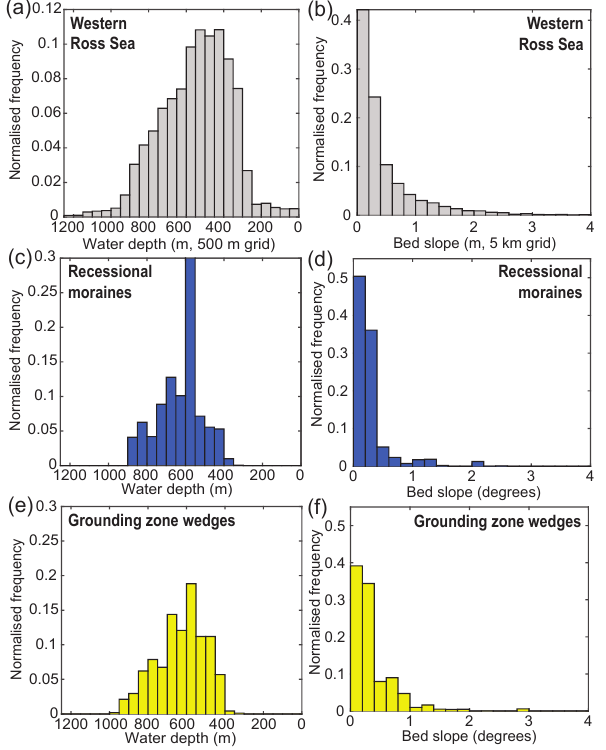
Figure 7. Water depth distribution across the western Ross Sea (a) and the water depths at which (b) recessional moraines and (c) grounding zone wedges occur. Bed slope distribution in the western Ross Sea (d) and the bed slope on which (e) recessional moraines and (f) grounding zone wedges are observed.